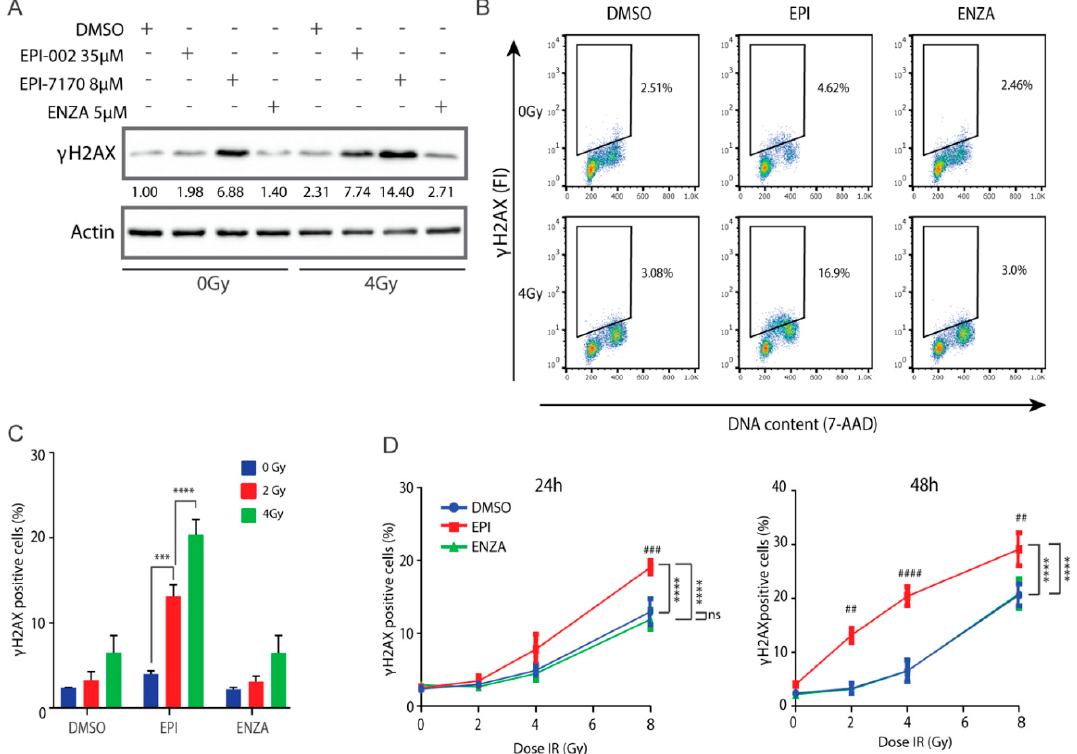
Figure 6. Ralaniten and EPI-7170 increase levels of γ H2AX whereas enzalutamide has little added benefit. ( A ) LNCaP95 cells were pretreated for 2h with DMSO, ralaniten (EPI-002), EPI-7170, and ENZA prior to IR (0 or 4 Gy) and then incubated for an additional 48 h before whole cell lysates were analyzed by Western blot using antibodies to γ H2AX and β -actin. Fold-induction values are provided under each γ H2AX protein band which were normalized to β -actin and basal levels in non-treated cells (DMSO, column 1). Uncut gels are provided in Figure S10. ( B ) Representative bivariate plots of cells stained with γ H2AX antibody and 7-AAD at 48 h after IR and pretreatment with DMSO, EPI-002 (EPI; 002 (EPI; 35 μ M), or ENZA (5 μ M). ( C ) LNCaP95 cells were treated as in B, stained for γ H2AX and 35 µ M), or ENZA (5 µ M). ( C ) LNCaP95 cells were treated as in B, stained for γ H2AX and analyzed by Flow Cytometry to measure the percentage of γ H2AX-positive cells. ( D ) Percentage of γ H2AX positive cells at 24 h and 48 h after various doses of IR and 2h pretreatment with DMSO, EPI-